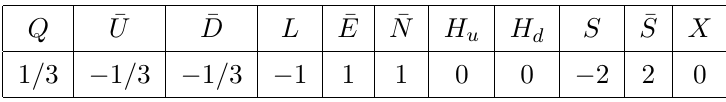
Table 3 . Charge assignment of U(1) B (cid:0) L